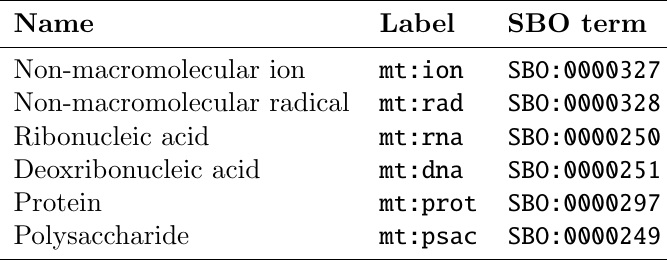
Table 2.2: A sample of values from the material types controlled vocabulary (Section 2.2.1).